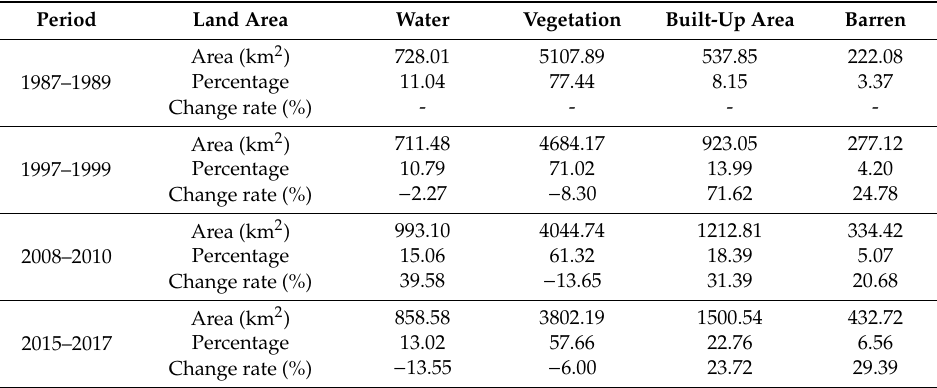
Figure 4. Four selected thematic land-cover maps of the Nanjing region in the lower reaches of the Yangtze River created in the Google Earth Engine (GEE) for 1987–1989, 1997–1999 (using Landsat 5 imagery), 2008–2010 (using Landsat 7 imagery), and 2015–2017 (using Landsat 8 imagery). Table 3. Land-cover and land-use change from 1987 to